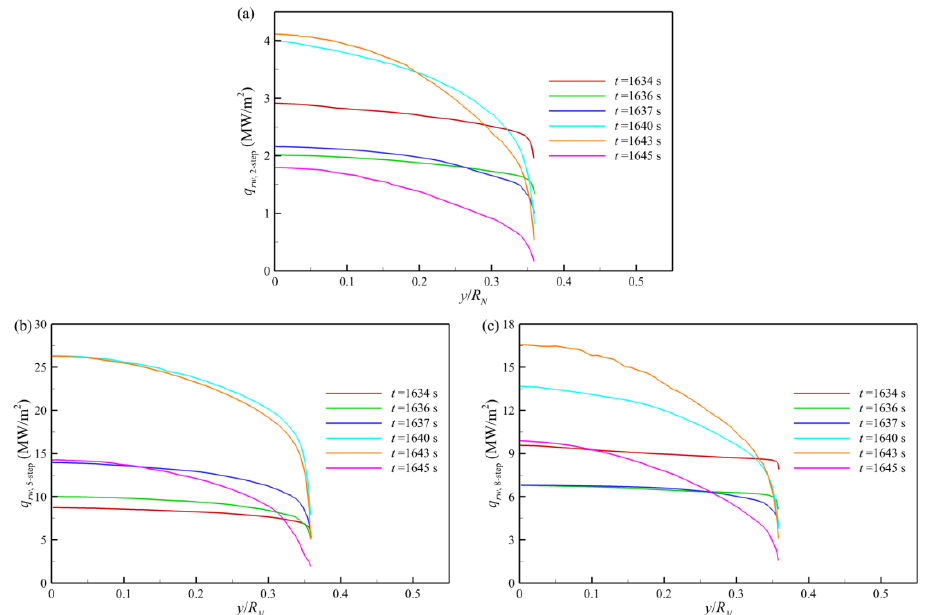
Figure 8. Forebody radiative heating throughout the trajectory predicted by ( a ) two-step model; ( b ) five-step model; ( c ) eight-step model.